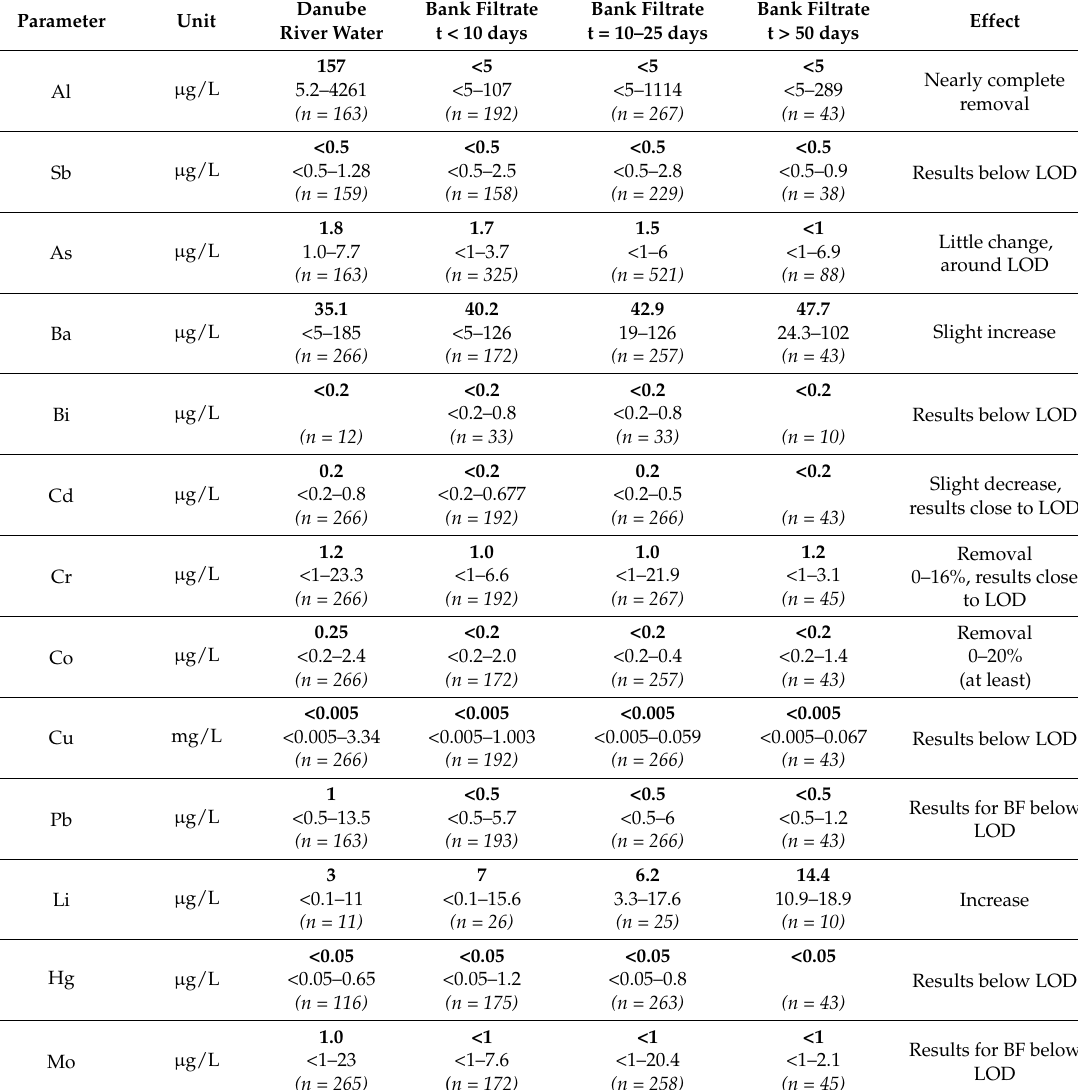
Table 4. Median (min–max) metal concentrations in Danube river water and bank filtrate (BF) with different travel time (t),